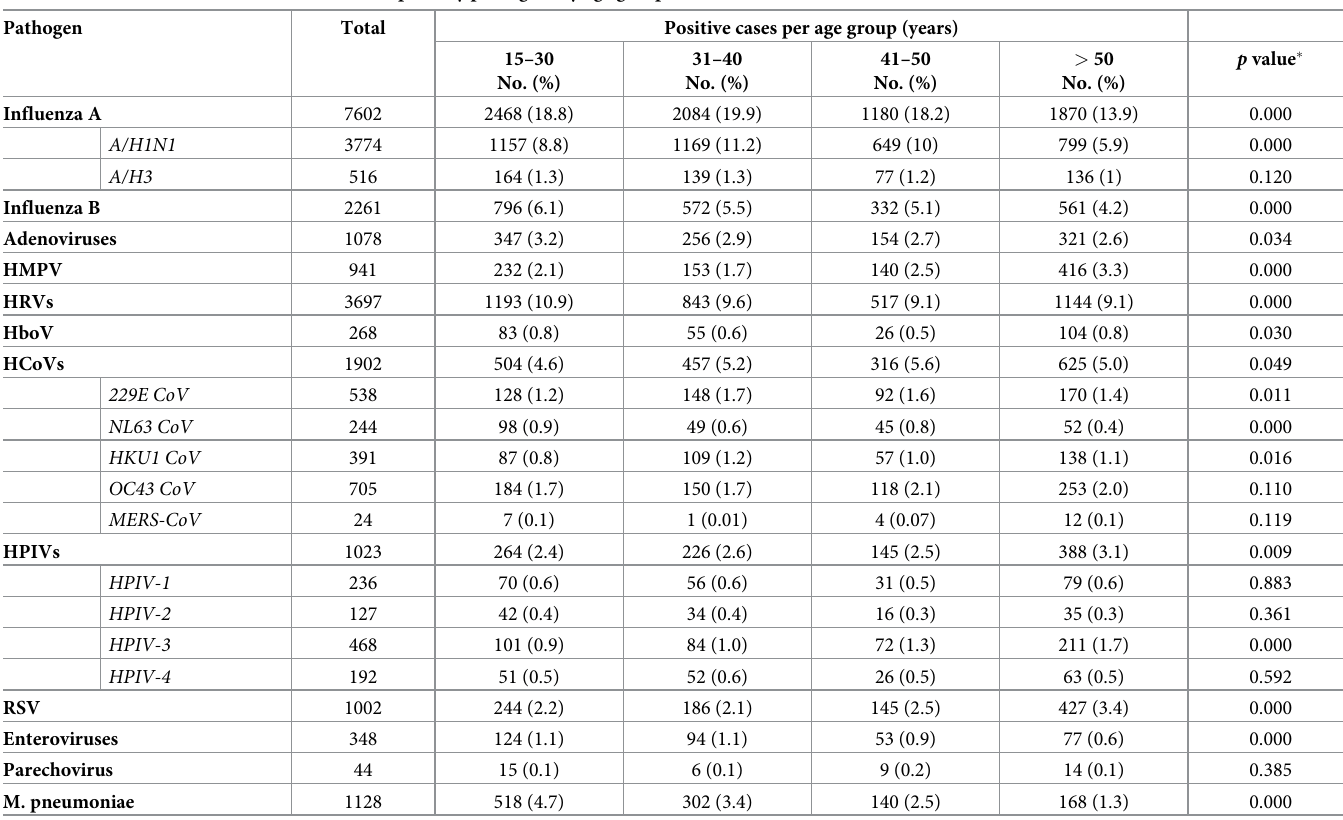
Table 4. Distribution of influenza and other respiratory pathogens by age